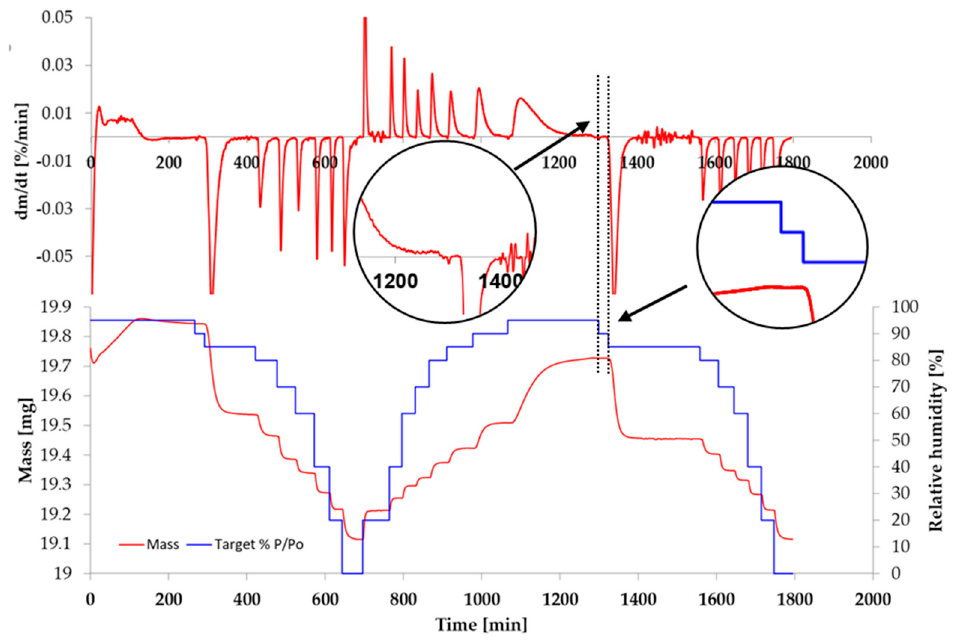
Figure 4. Sorption kinetics of the AAC and an example of a delayed response error.